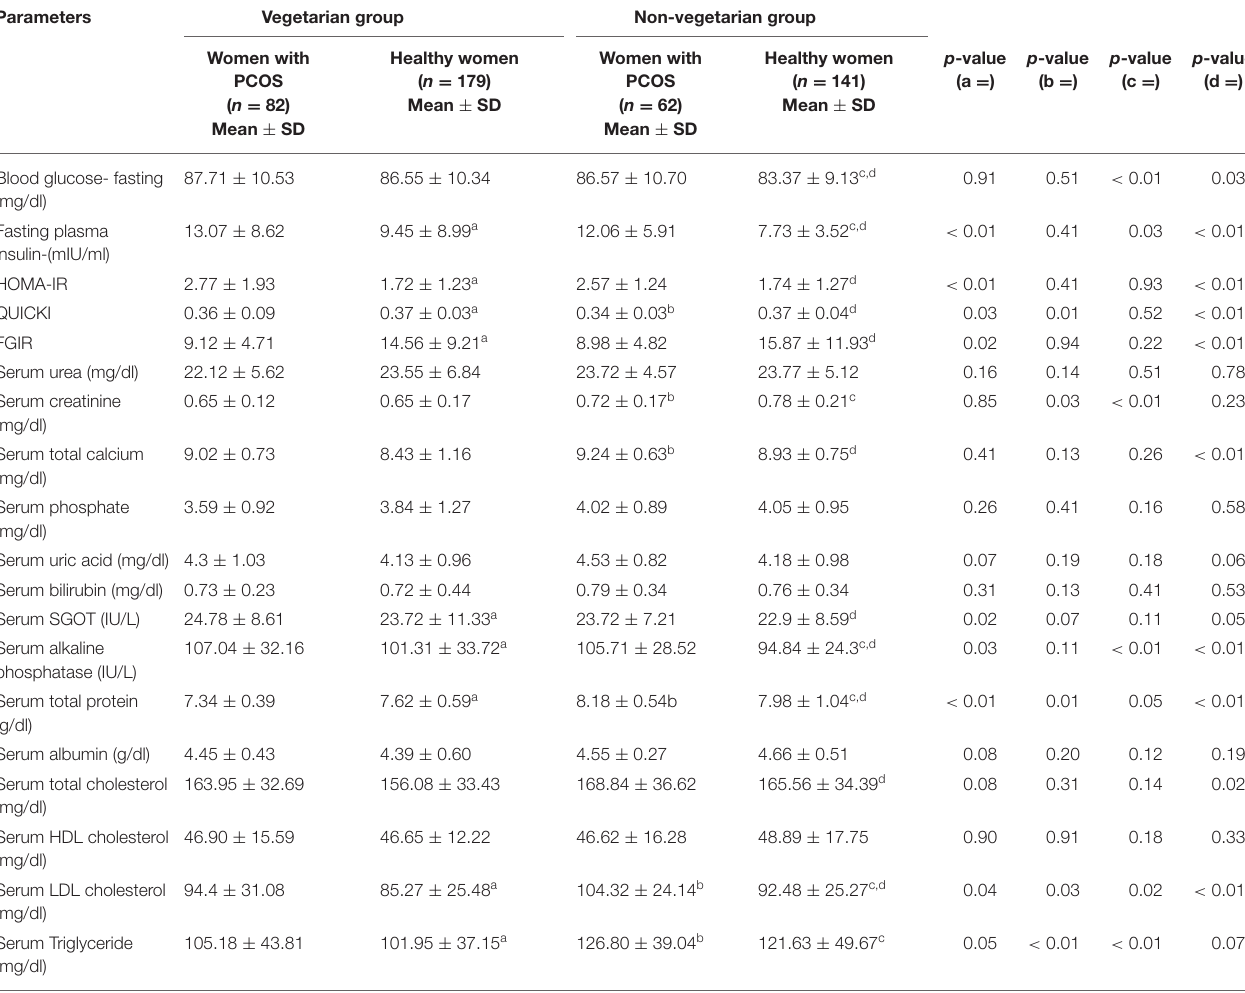
TABLE 2 | Showing comparison of biochemical parameters among healthy women and women with PCOS from Delhi and Srinagar. Parameters